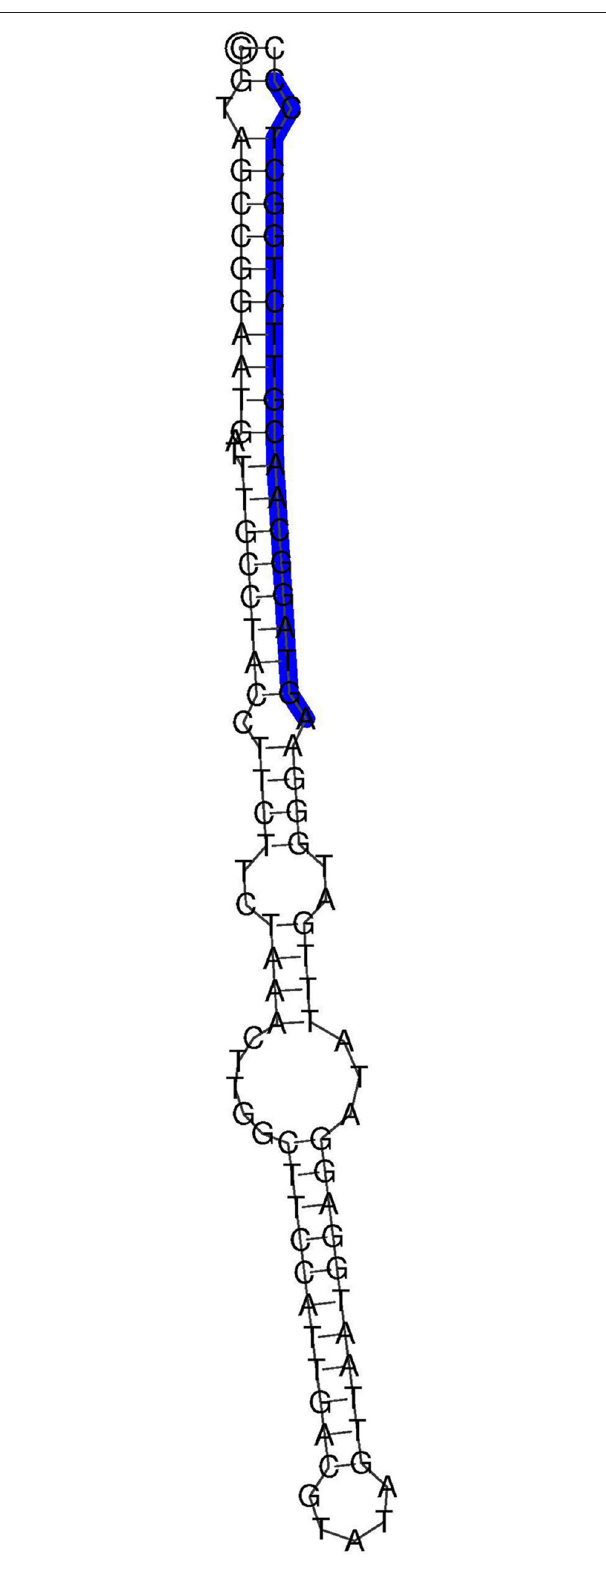
FIGURE 2 | Predicted secondary structure for